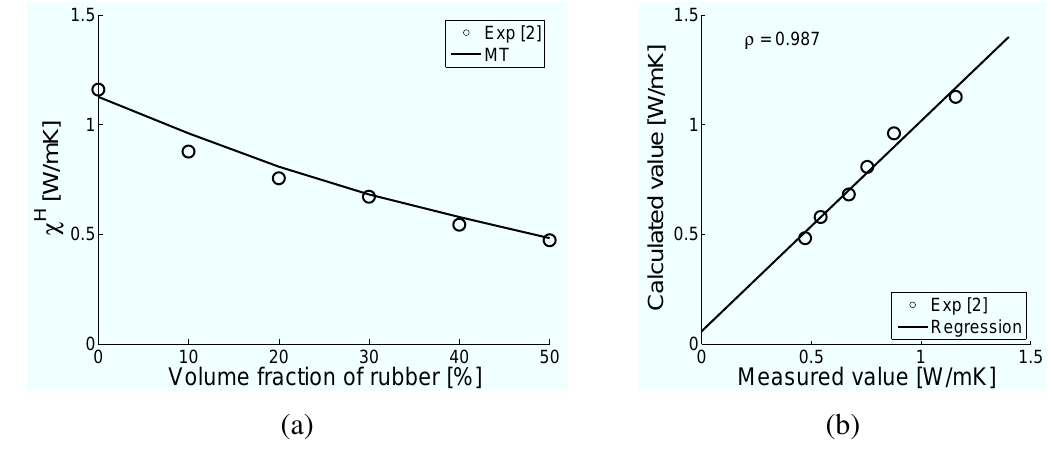
( a ) Evolution of effective thermal conductivity χ H as a function of volume fraction of rubber in solid phase, ( b ) Correlation of measured and calculated values; ρ is the correlation